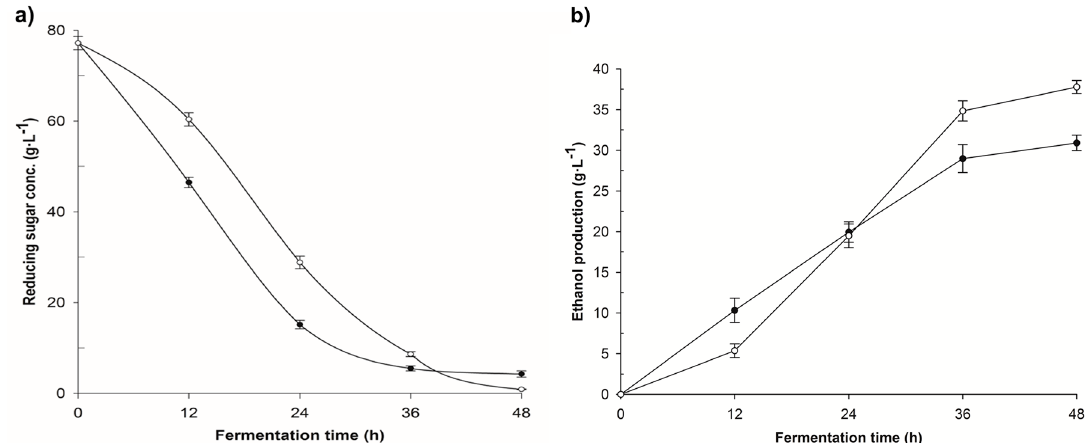
Figure 4. Fermentation profile of flour from B. alicastrum using two yeast strains: Solid symbols ( S. cerevisiae, Safoeno ® ) and open symbols ( C. tropicalis , PL1). ( a ) Represents the consumption of reducing sugars and ( b ) shows ethanol production. The results are represented as the mean ± standard deviation of three parallel measurements ( n = 3).